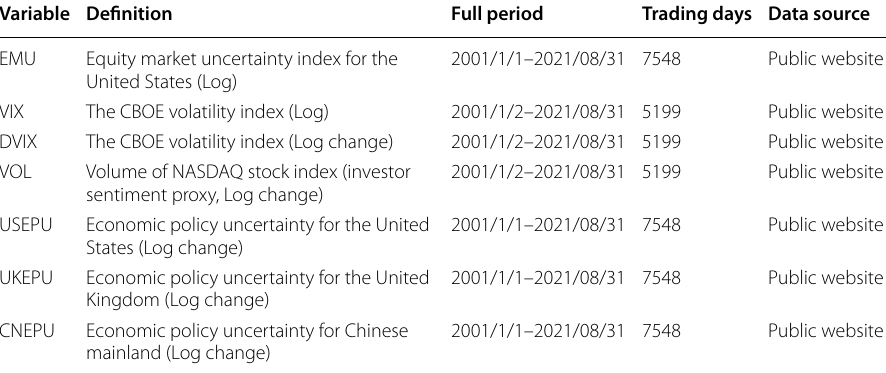
Table 1 Definition of uncertainty